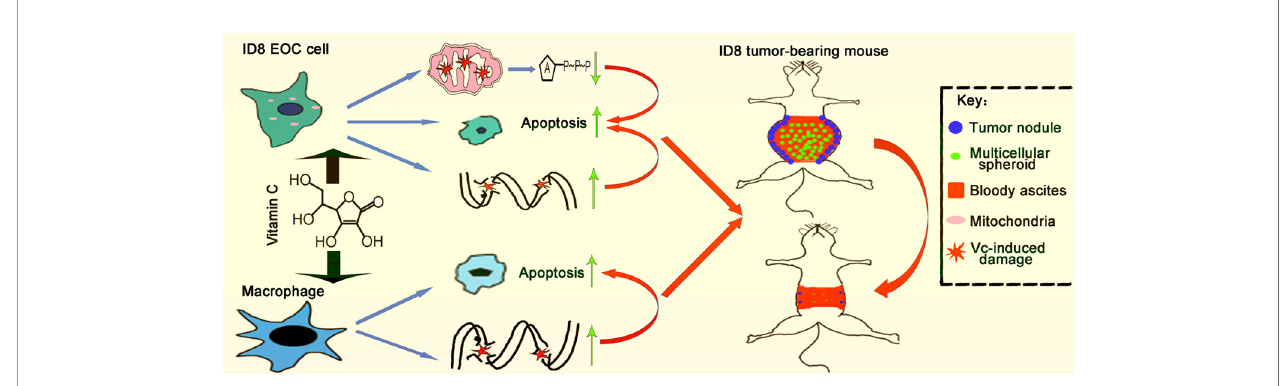
FIGURE 10 | Schematic illustration of vitamin C inhibits metastasis of peritoneal tumors in ID8 murine epithelial peritoneal